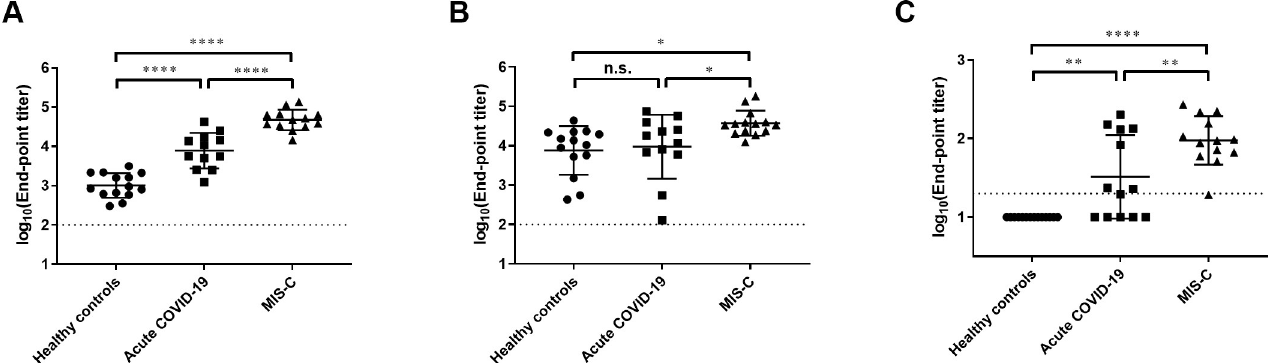
Fig 3. HKU1 antibodies are prevalent in healthy children and children with acute COVID-19 and MIS-C. SARS-CoV-2 (A) and HKU1 (B) spike IgG antibody titers and FRNT neutralization titers (C) in healthy pediatric controls compared to children hospitalized with acute COVID-19 and MIS-C. Each dot represents a unique patient, and data represent the geometric mean titers of � P < 0.05; �� P < 0.01; ��� P < 0.005; ���� P <